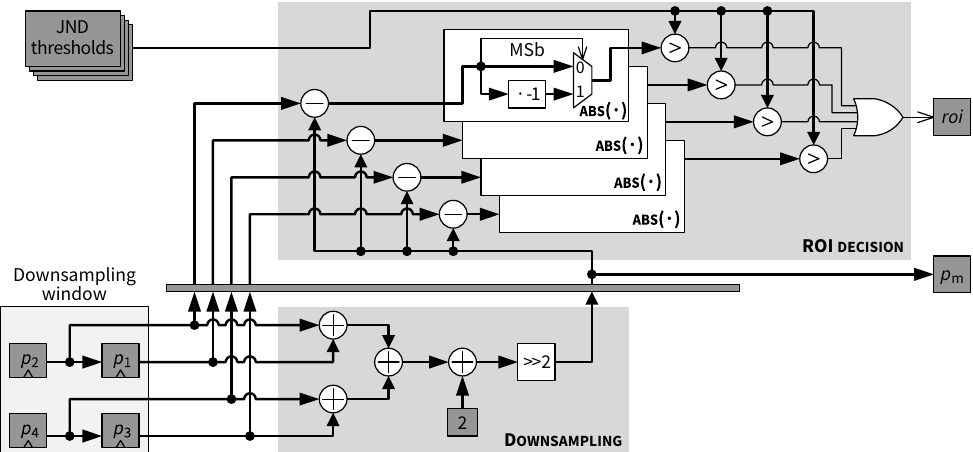
Figure 21. Downsampling and ROI decision